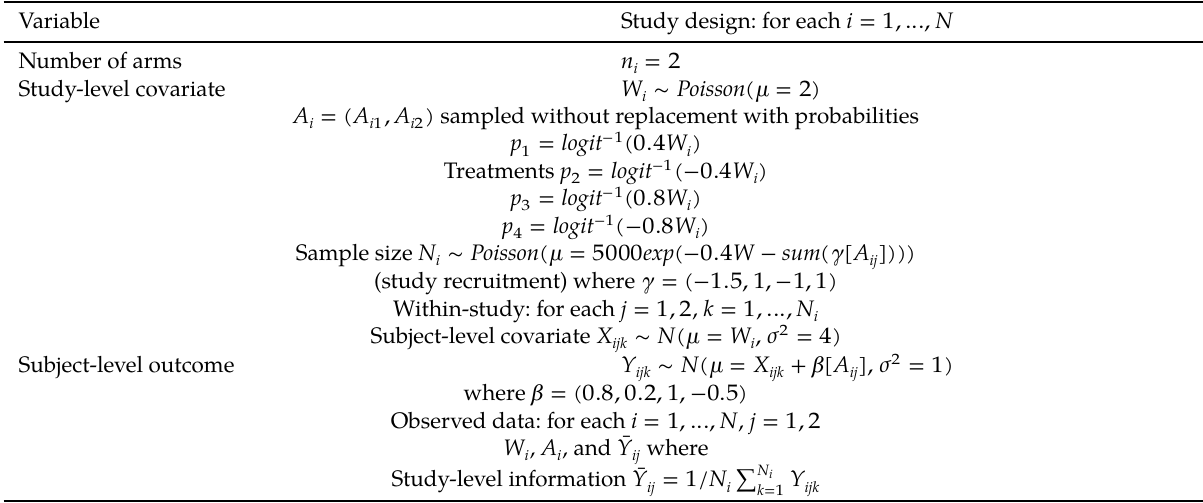
Table 1: Simulation study: data generation. Variable Study design: for each i =  ,..., N Number of arms n Study-level covariate W